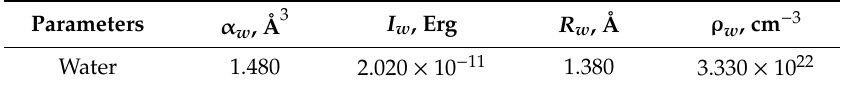
Table 2. Polarizability, ionic potential, and radius of the water molecule and density of the of the water molecules in the bulk of water